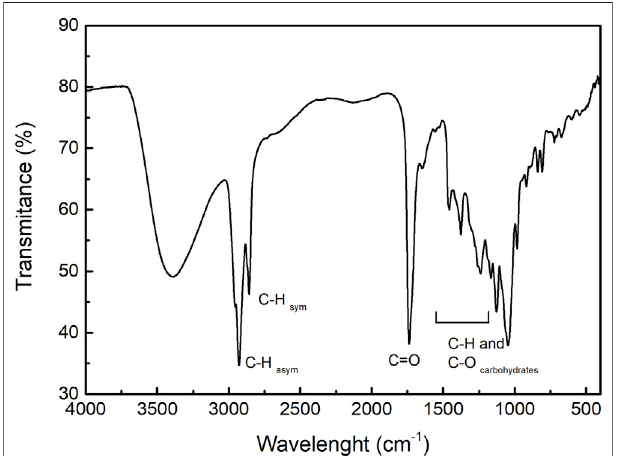
FIGURE 1 | FTIR spectrum of rhamnolipids.